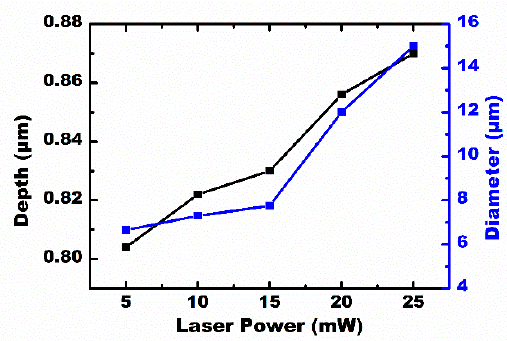
Figure 5. The dependencies of the diameter and depth of the concave microlens on laser power.